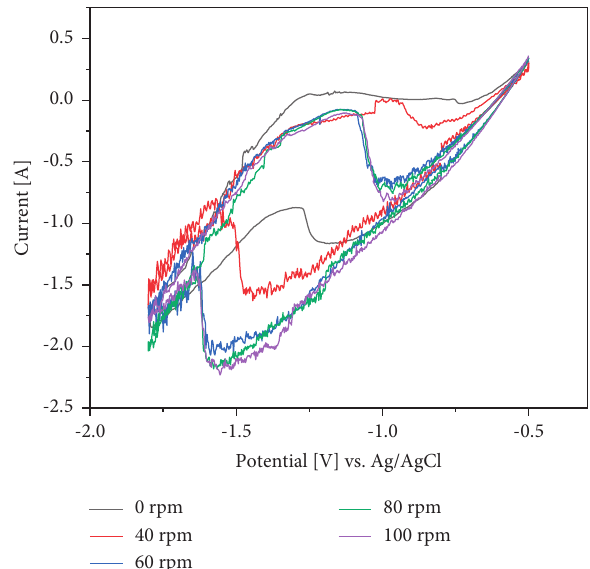
Figure 2: Cyclic voltammograms of the liquid Cd electrode in LiCl- KCl-UCl 3 at 500 ° C with various Cd stirring rates.